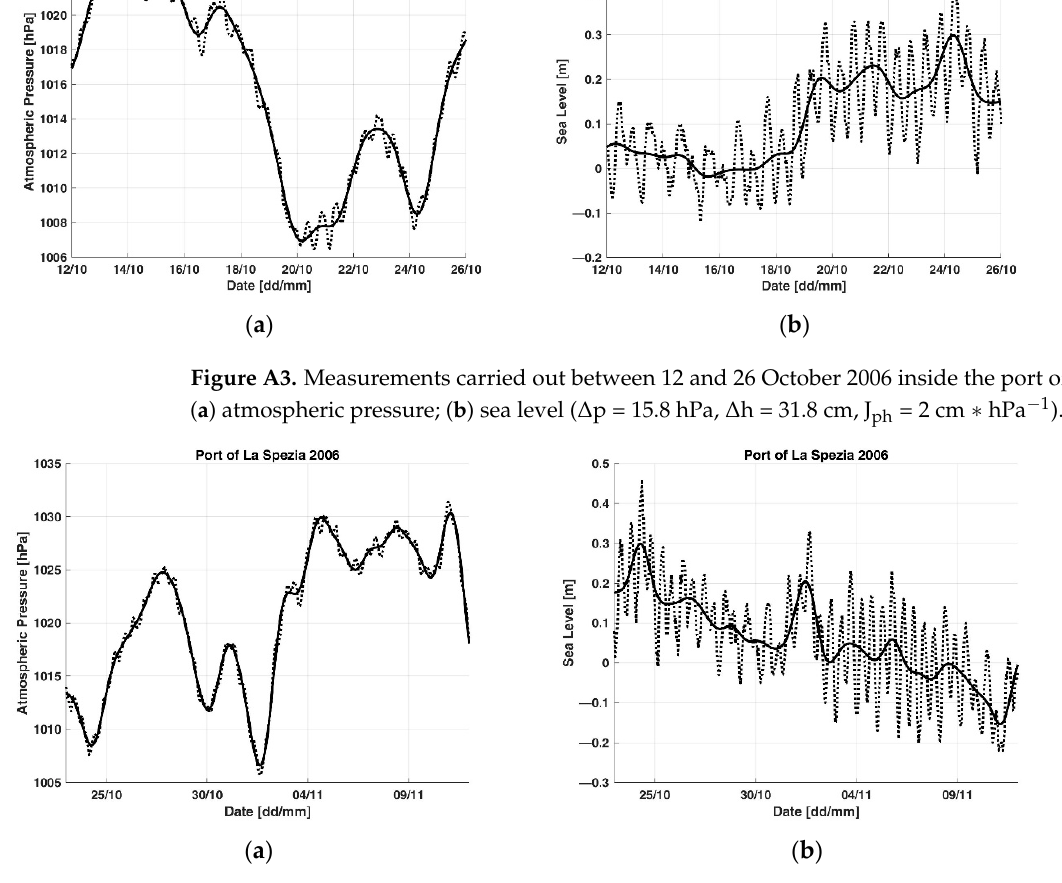
Figure A4. Measurements carried out between 23 October and 12 November 2006 inside the port of La Spezia: ( a ) atmospheric pressure; ( b ) sea level ( Δ p = 23.8 hPa, Δ h = 45.3 cm, J ph = 1.9 cm * hPa − 1 ).